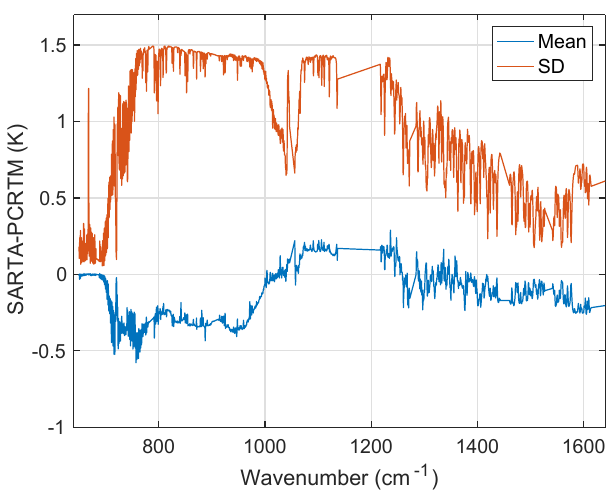
Figure 2. Spectral differences for clear-sky calculations between SARTA and PCRTM for ocean night scenes. Also shown are the AIRS noise levels. Typical difference between PCRTM and SARTA are less than 0.25K, except in the methane region (1300cm − 1 ) where SARTA does not use line mixing and in some of the strong water vapor lines (1400+cm − 1 ).